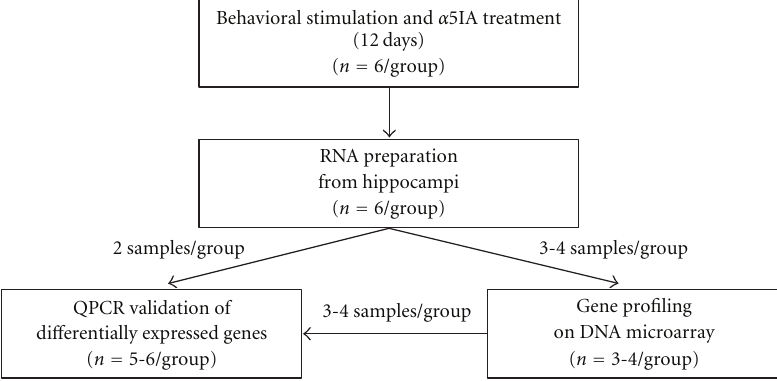
Figure 1: Experimental design used for the genomic studies: microarray and